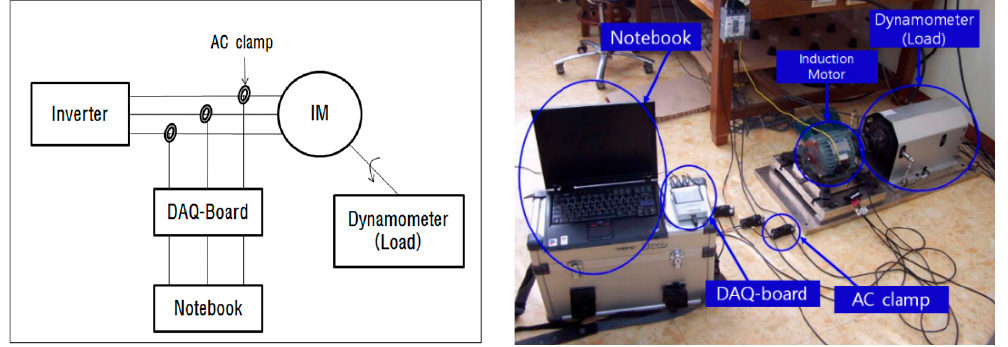
Figure 8. Experimental device configuration.